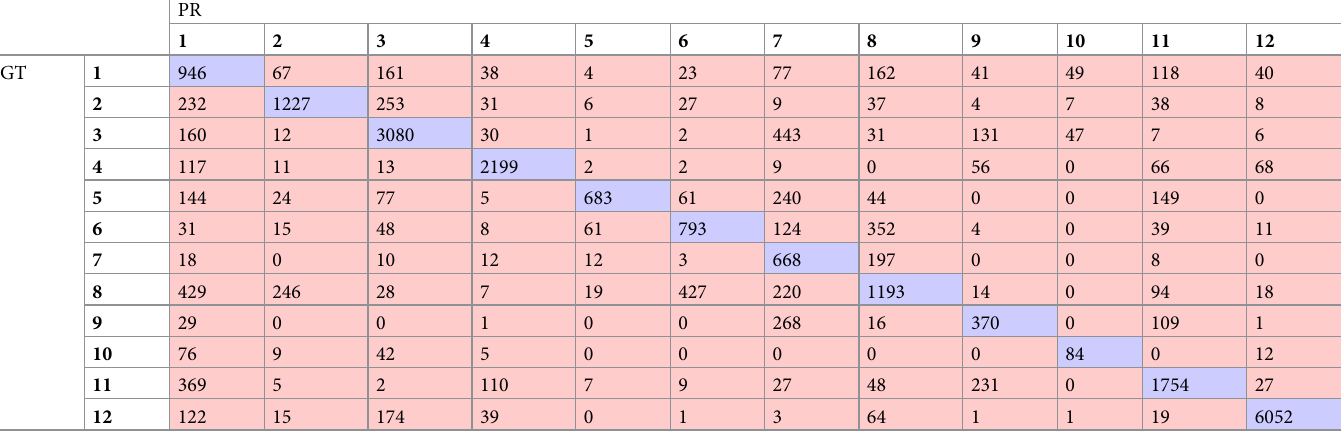
Table 10. Confusion matrix of our model’s result (test set). The rows show the classes of the groundtruths (GT). The columns show the classes predicted by the model (PR). The value of each element is a count of the pairs of the GT and the PR. The diagonal line is the true positive and is expressed in a blue cell. The class numbers in the table correspond to the class IDs in Table